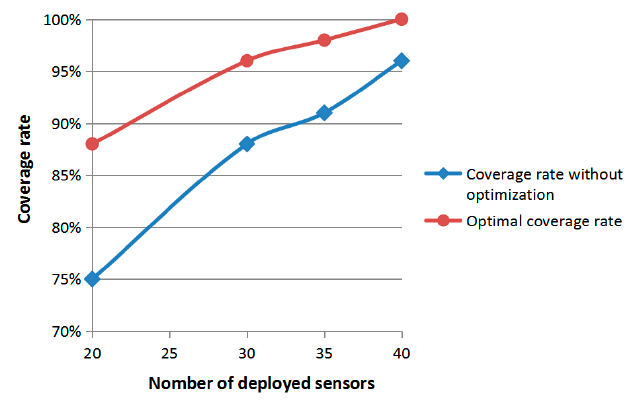
Figure 7. Coverage rate compared to the number of sensor deployment.